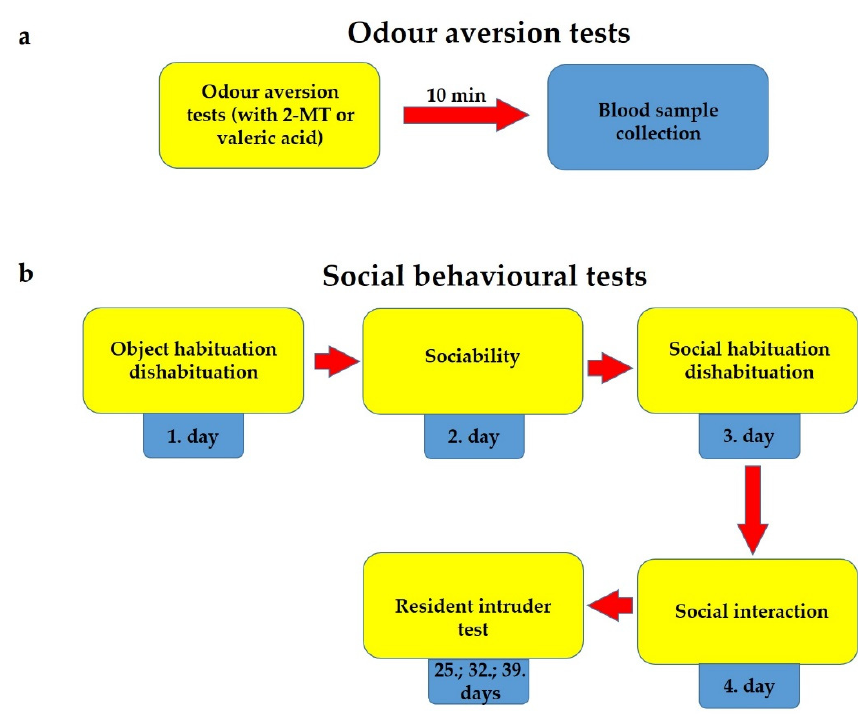
Figure 11. Schematic representation of the process of odour aversion ( a ) and social behavioural experiments ( b ), carried out on Trpa1 knockout mice and their wild-type siblings.